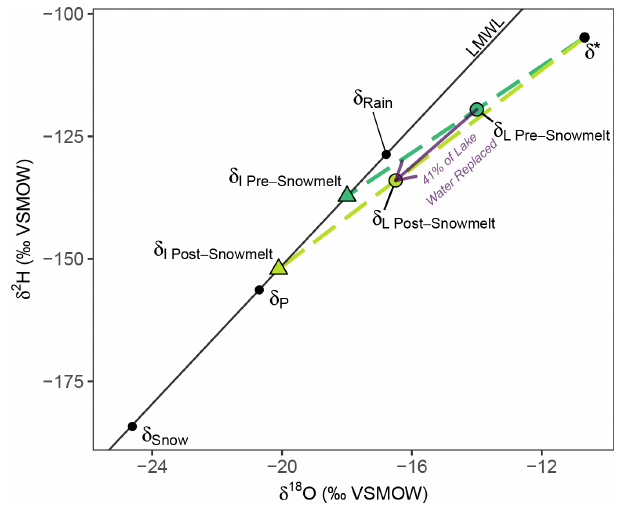
Figure 4. A hypothetical change in the isotopic composition of lake water from pre-snowmelt to post-snowmelt is shown. A visualiza- tion of how δ I is calculated for an individual lake using a lake- specific evaporation line for both pre-snowmelt and post-snowmelt is also shown, where each lake’s evaporation line (dashed line) ex- trapolates from δ ∗ through δ L until intersecting the local meteoric water line to give δ I . The local evaporation line (LEL) is defined by the line between δ P and δ ∗ (not